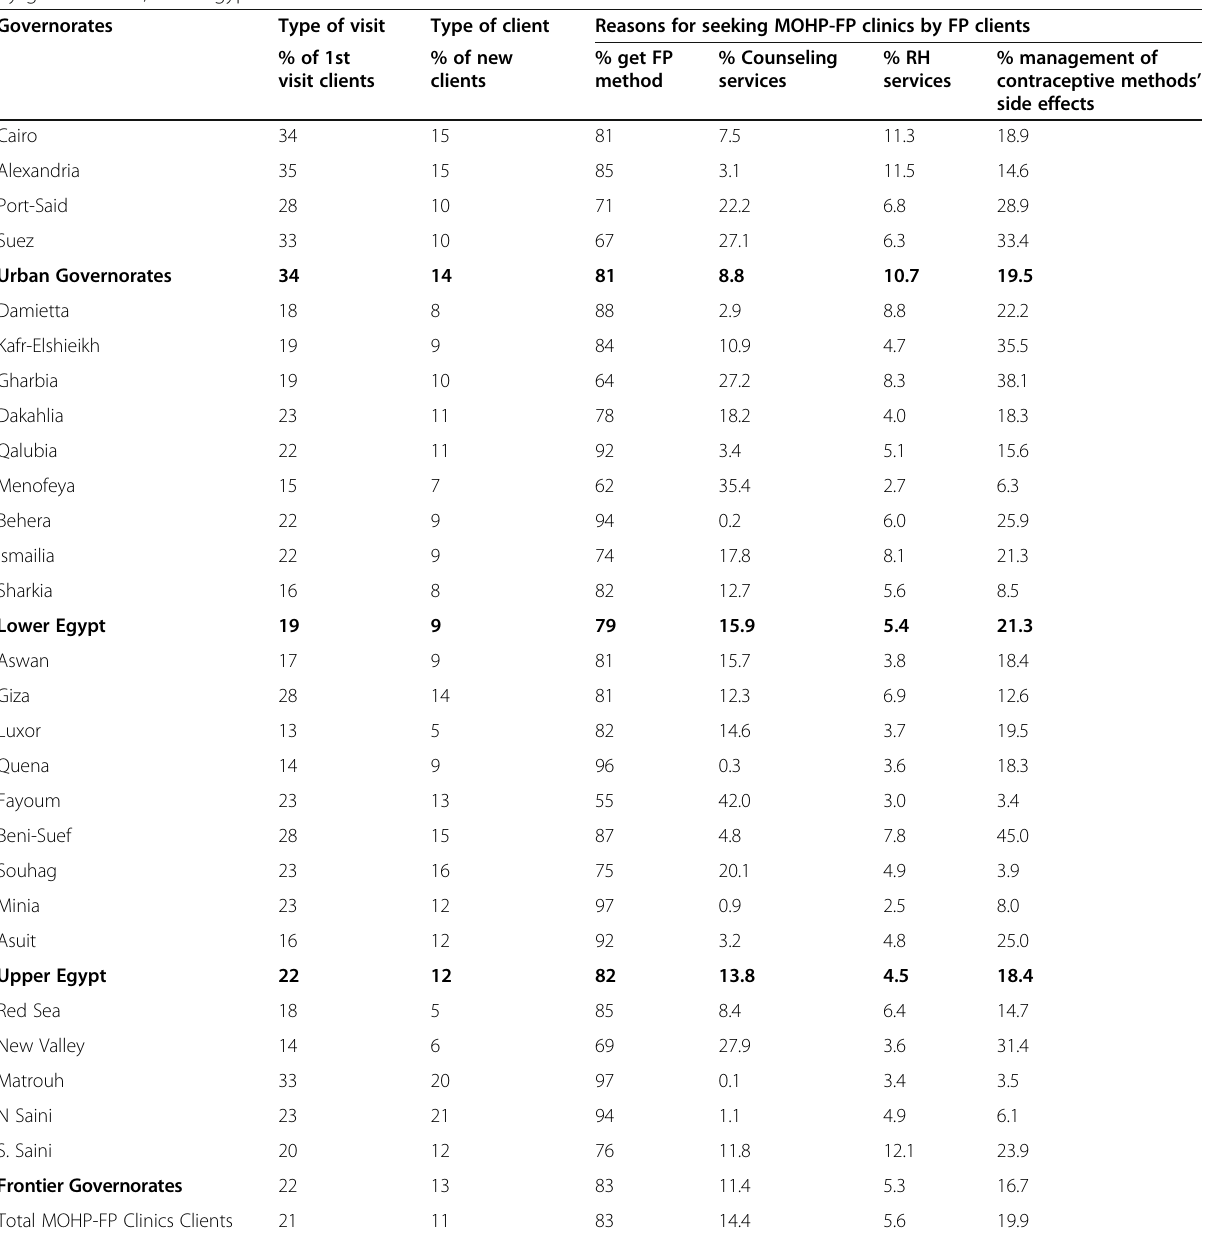
Table 4 Distribution of MOHP-FP clients according to type of the visit, type of client, and reasons for seeking services at FP clinics, by governorates, 2014